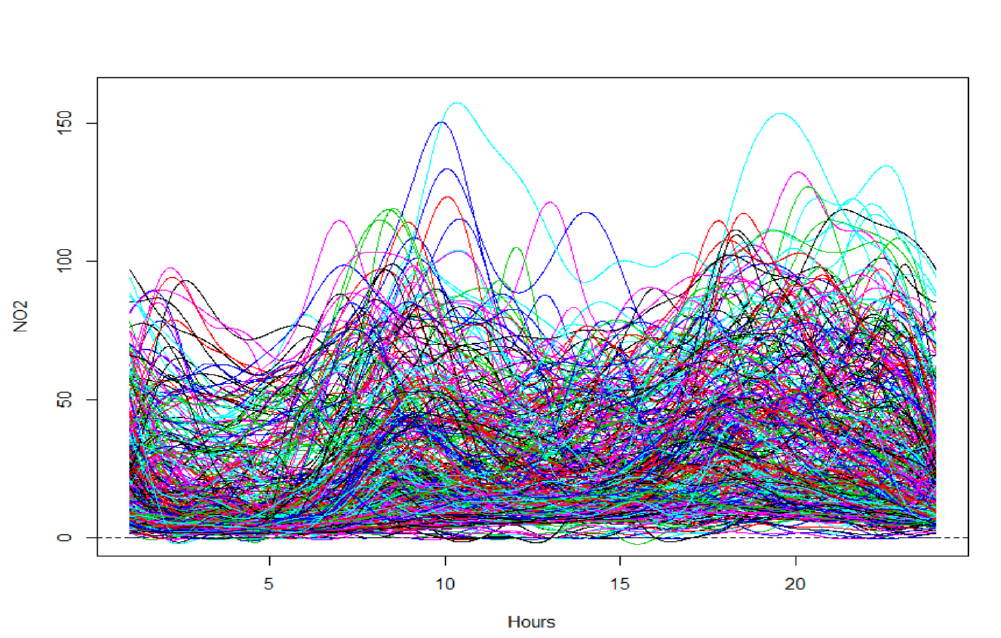
Figure 13. Data represented in functional form (functions): 365 daily curves of NO 2 emissions. Software: R-programming